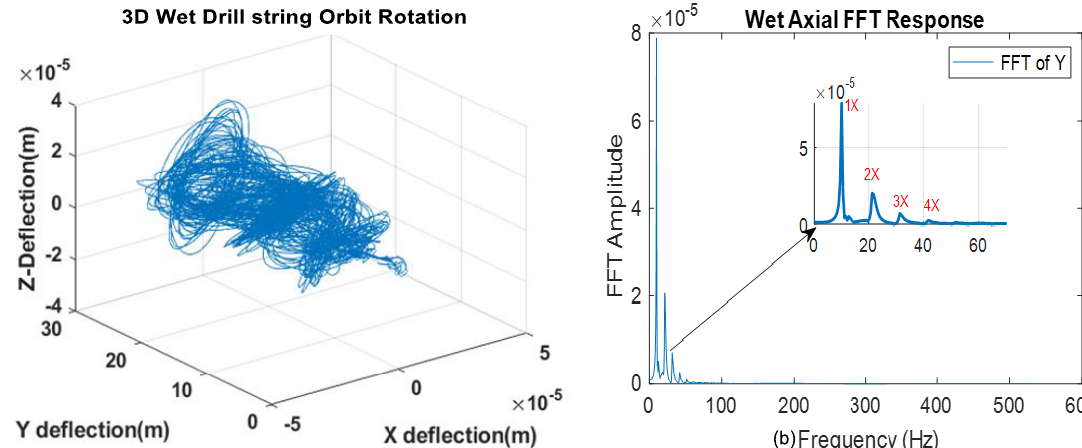
Figure 11. Response of the imbalanced drill string-casing system with rubbing in an inviscid fluid. ( a ) 3D imbalanced drill string response orbit in fluid with rub; ( b ) FFT response of imbalanced and rubbed drill in fluid.